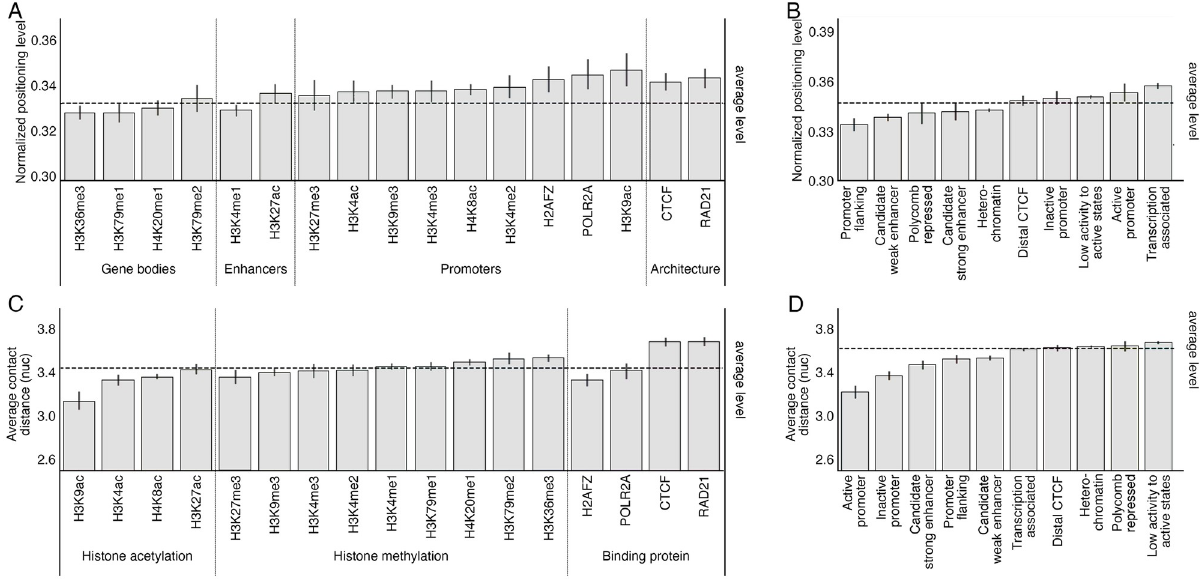
Fig 3. Nucleosome positioning levels and spatial organization are correlated with patterns of epigenetic modifications and genome functions. A. Normalized nucleosome positioning level at nucleosomes subject to specific epigenetic modifications or protein bindings. Generally, nucleosomes modified by promoter enriched epigenetic marks or at chromatin architecture associated protein binding sites are better positioned. Meanwhile, nucleosomes modified by gene body enriched or enhancer enriched epigenetic marks are more poorly positioned. B. Normalized nucleosome positioning level at nucleosomes within different chromatin states predicted by ChromHMM. Similar to the observation in epigenetic modifications, nucleosomes in promoters are better positioned, while nucleosomes in promoter flanking regions and enhancers are more poorly positioned. Transcription associated state represents loci of RNA polymerase binding or mRNA elongation, which mostly occur near active promoters. C. Average distances of local contacts (contact distances � 1kb) at nucleosomes subject to specific epigenetic modifications or protein bindings. A longer contact distance suggests more compact nucleosome spatial organization, while a shorter contact distance suggests more relaxed nucleosome spatial organization. Generally, nucleosomes modified by histone methylations are more tightly packed than nucleosomes modified by histone acetylations, and the spatial organization of nucleosomes at protein binding sites varies across different protein functions. D. Average distances of local contacts (contact distances � 1kb) at nucleosomes within different chromatin states predicted by ChromHMM. Compared with other states, nucleosomes at enhancers and promoters are more lightly packed regardless of their activities, resulting in shorter average contact